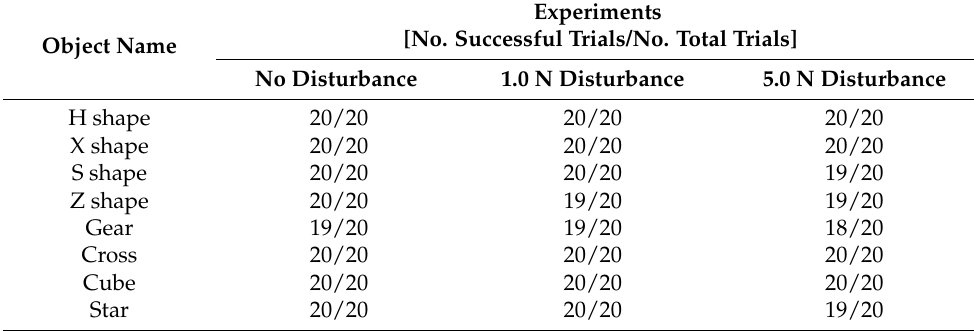
Table 1. The success rate of the proposed four-pin gripper.